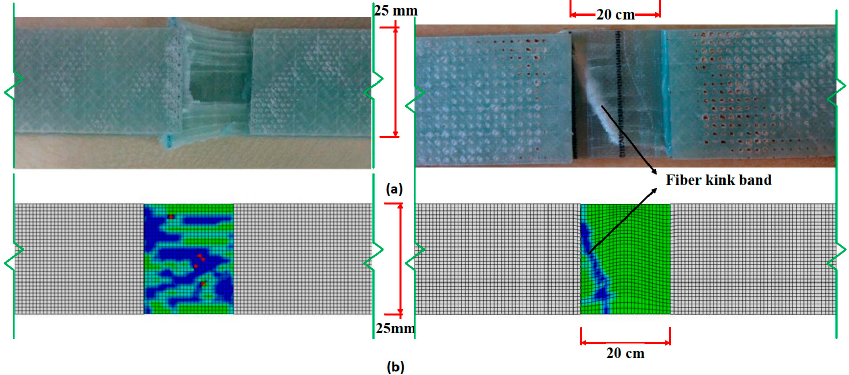
Figure 9. ( a ) Experimentally failed specimens and ( b ) model prediction of both defect ‐ free and waviness defect ‐ containing samples.